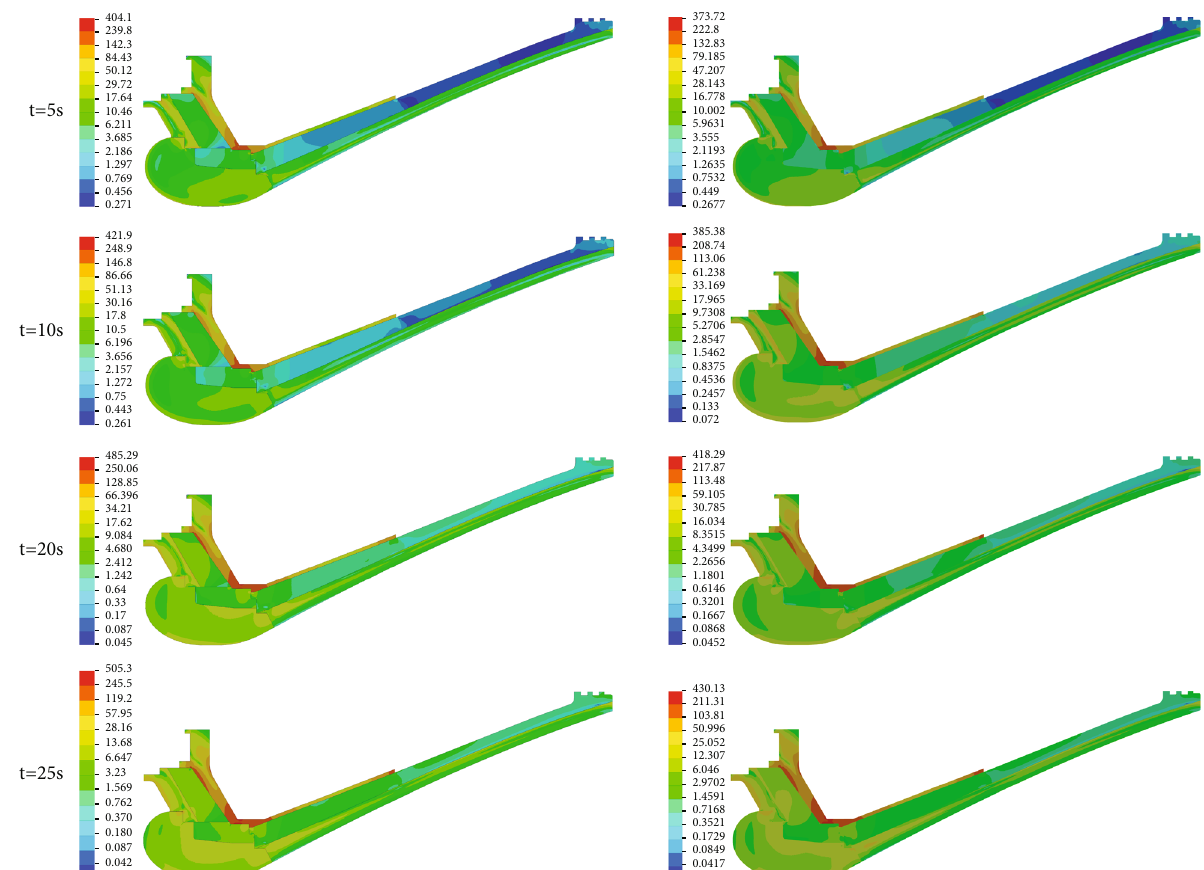
Figure 13: Graphs of Von Mises stress distributions